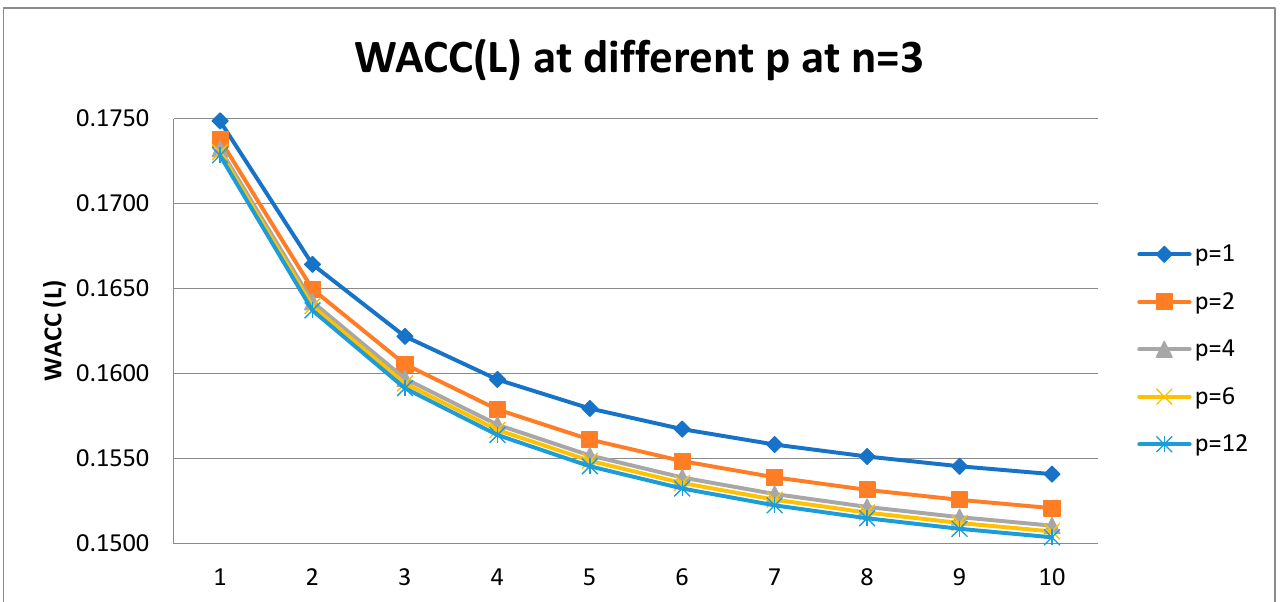
Figure 4. Dependence of the weighted average cost of capital, WACC , on leverage level L at different frequency of payments of tax on profit p for three-year company.